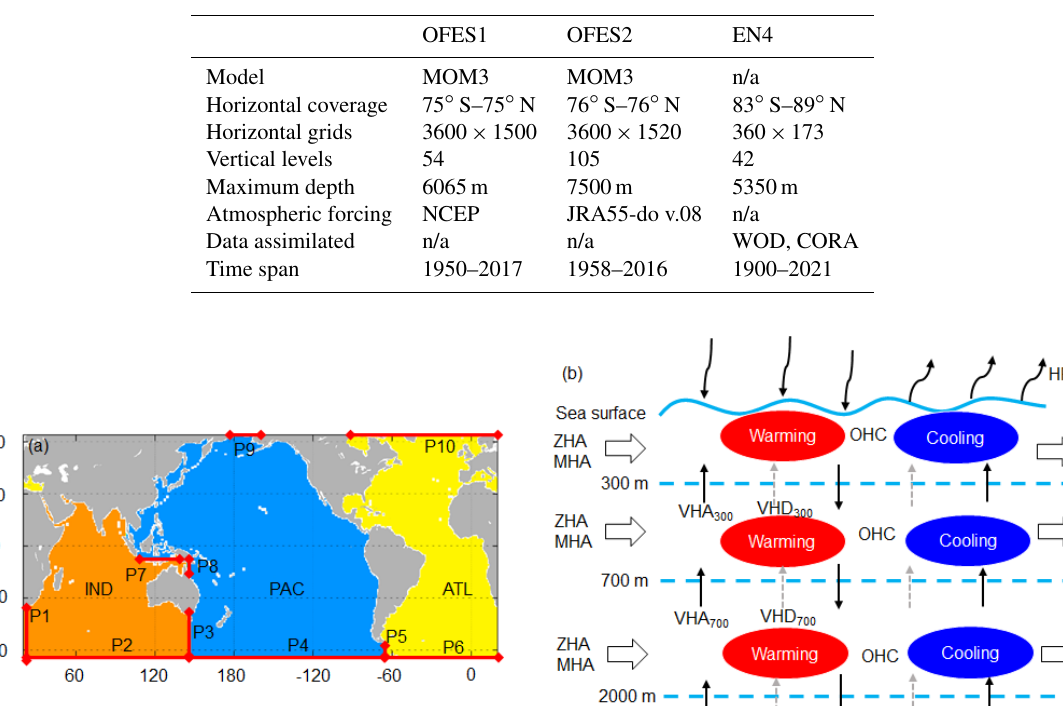
Table 1. A summary of OFES1, OFES2 and EN4. “n/a” means “not applicable”.